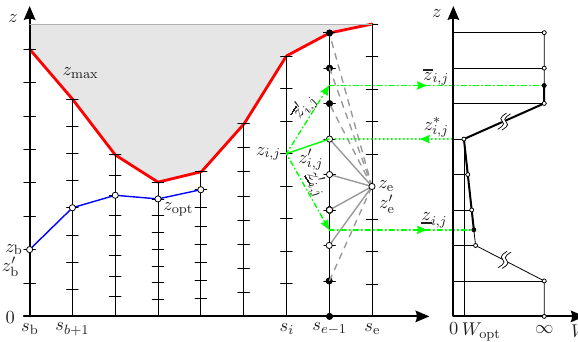
Figure 4. Feasible region in the z × z (cid:48) plane with max z (cid:48) z (cid:48) at z j . j